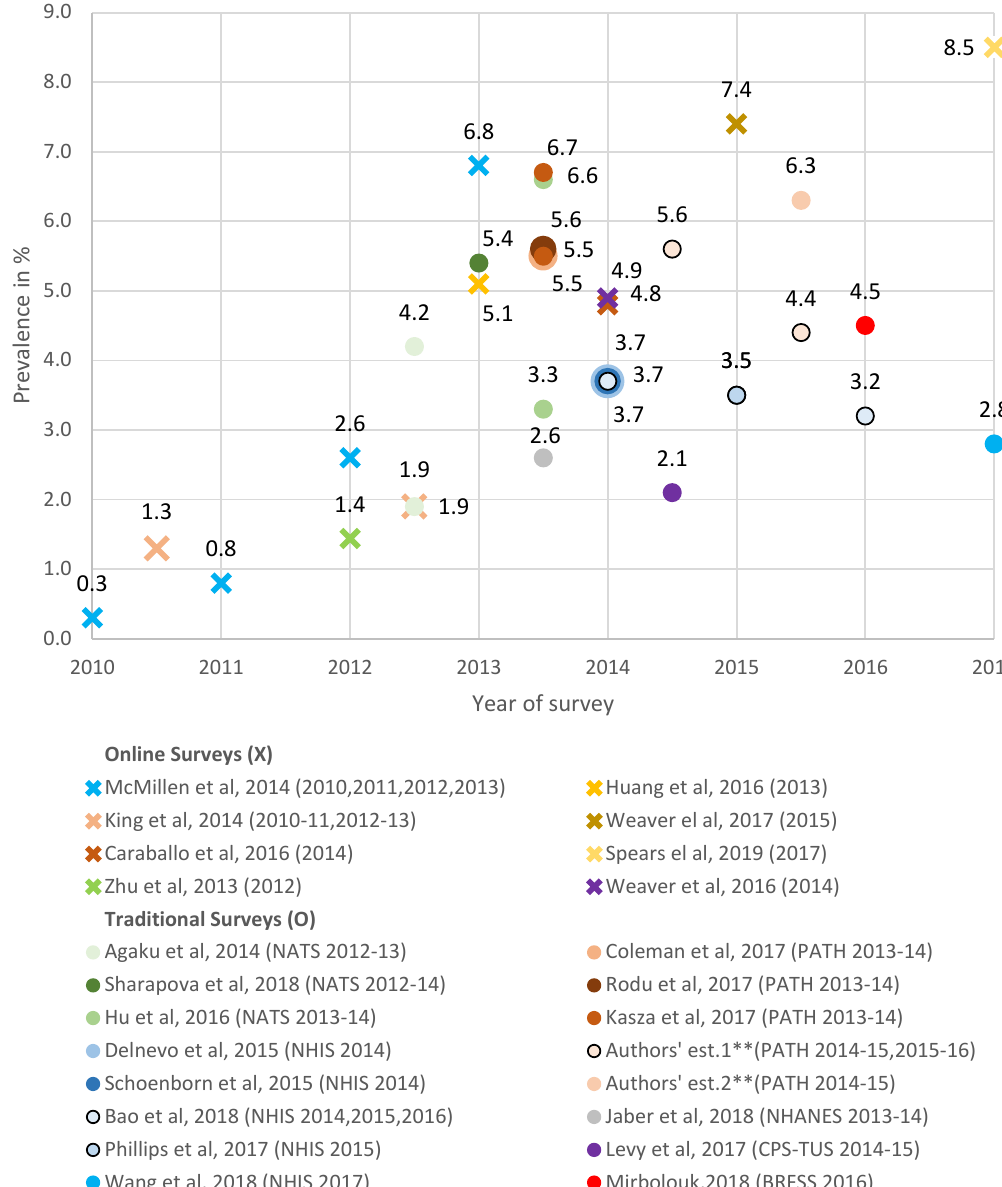
Figure 1. The prevalence of current e-cigarette / ENDS use among the total adult population, online and traditional survey estimates *, 2010–2017. * The estimates from online surveys are indicated by an X, and the estimates from traditional surveys are indicated by a circle. The legend adopts the format “author’s name, publication year (survey name and year(s)),” and the names of all online surveys are omitted. For surveys that collected data over a two-year period, we plotted the estimates in the mid-period (e.g., the estimate 2.6% from Jaber et al. using NHANES 2013–14 is plotted in 2013.5). ** Authors’ estimate one is measured by daily / non-daily ENDS use, and authors’ estimate two is measured by past-30-day ENDS use.